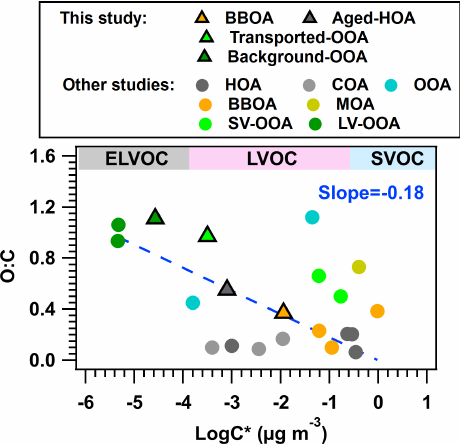
Figure 10. Scatter plot of O : C and average log C ∗ from this and previous studies. MOA represents marine OA. The detailed values in this plot are exhibited in Tables